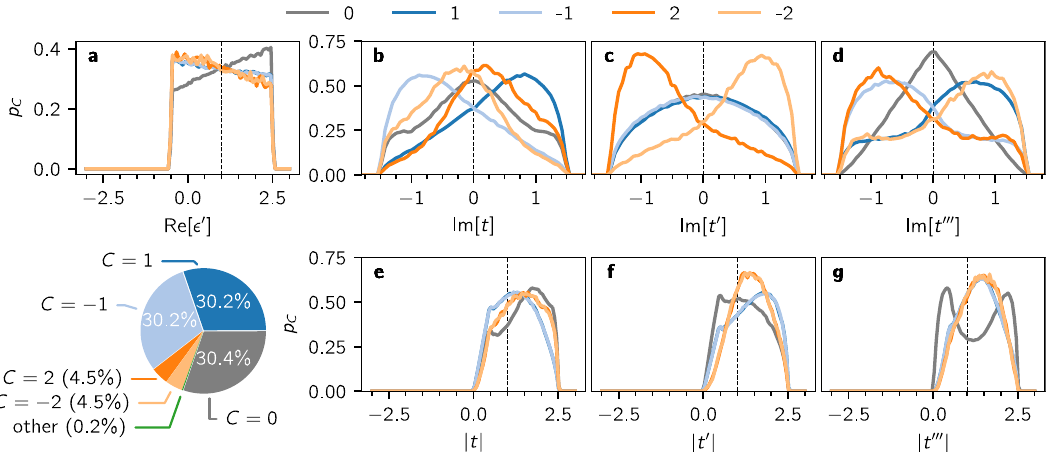
Fig. 3 Chern numbers and marginal probability distributions. Distribution of Chern numbers (pie chart) and a – g marginal PDFs for the most descriptive features of insulators within the 2 × 2 kagome superlattice with C 6 symmetry. The pie chart shows the percentages of trivial ( C = 0) and topological ( C ≠ 0) samples obtained out of all insulating samples. For the PDF plots corresponding to different feature components, grey lines denote trivial phases ( C = 0) and colored lines denote non-trivial ( C ≠ 0) phases as indicated by the legend on top. Dashed vertical lines indicate the reference